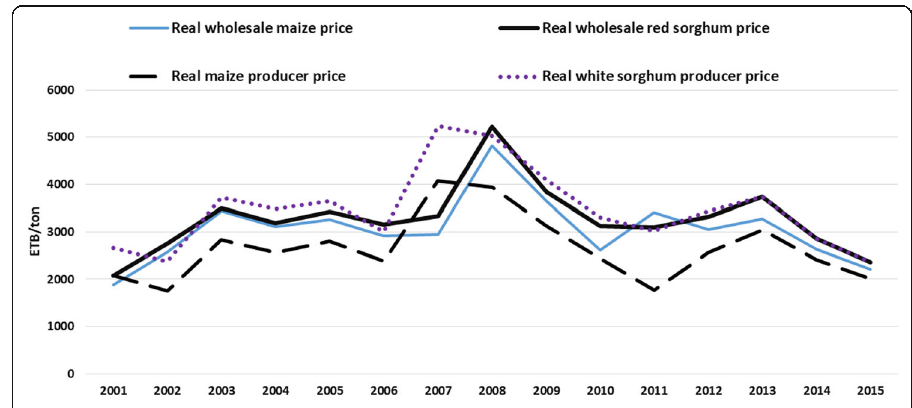
Fig. 1 Trends of real producer and wholesale sorghum and maize prices, 2001 – 2015. Source: Author ’ s computation from FAO data (FAO (Food and Agriculture Organisation of the United Nations)